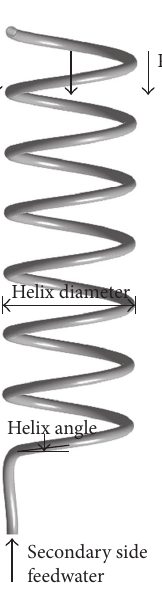
Figure 2: Structure and flow of H-OTSG. Table 3: Parameters for H-OTSG simulation in a single pipe. Parameters